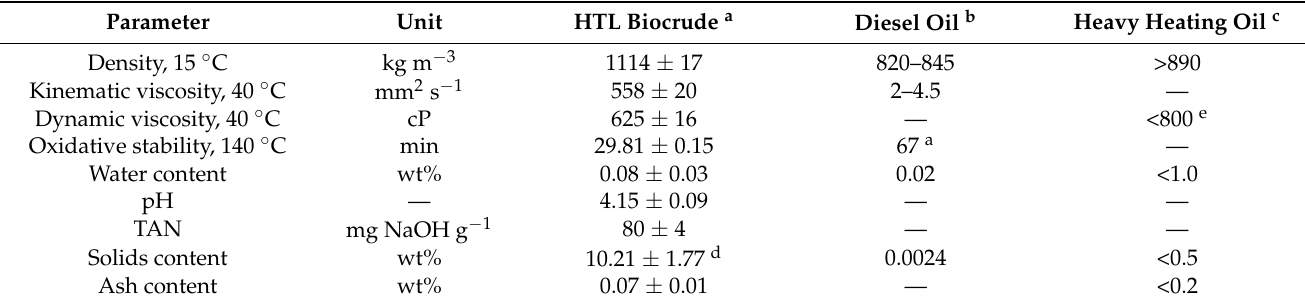
Table 4. Physicochemical characteristics of obtained HTL biocrude and standard requirements for the reference conventional